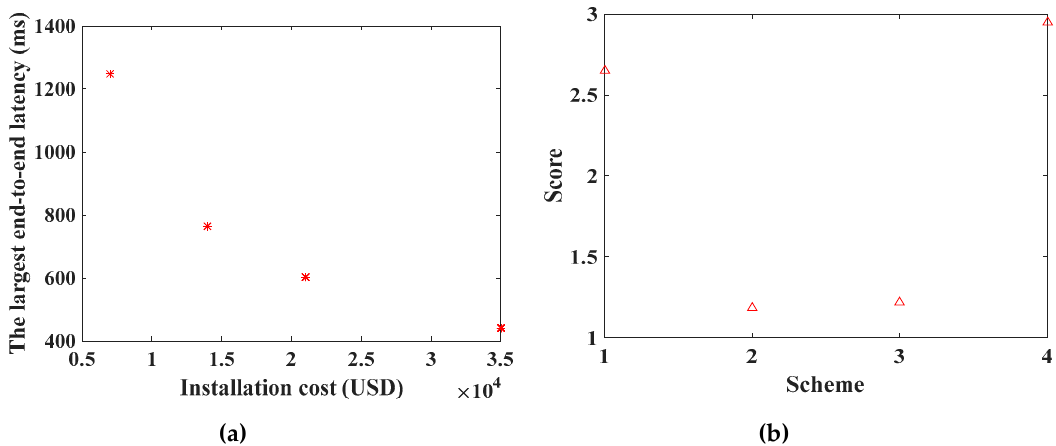
Figure 14. The results of WCN deployment based on SinPSO: ( a ) the Pareto frontier of optimization objective function of WCN installation cost and end-to-end delay; ( b ) the comprehensive attribute score of each deployment scheme of WCN.